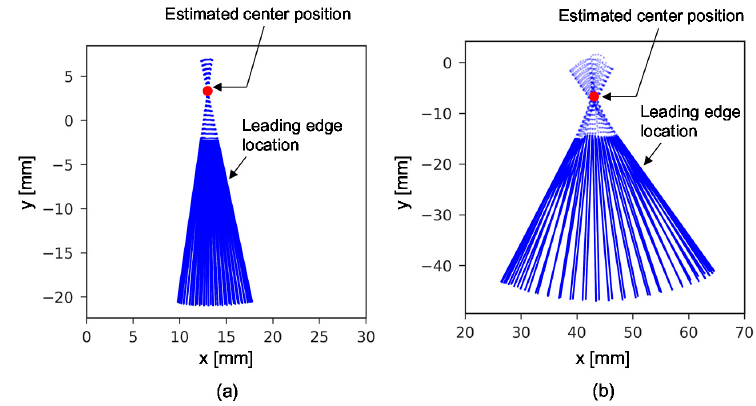
Figure 8. Estimated center position of wing stroke rotation from captured images: ( a ) small type with V 0 = 30 V and ( b ) large type with V 0 = 50 V. Blue solid lines indicate the location of the leading edge and dotted lines, their extensions. The red point indicates the estimated center position.